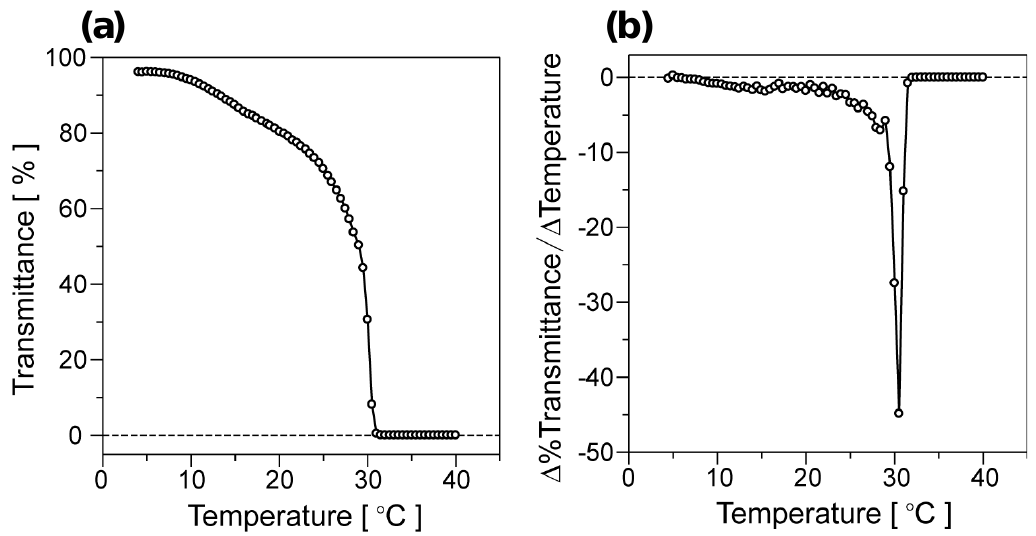
Figure 4. Temperature-dependent optical transmittance variation of poly(NIPAAm- block -NIPAAm- co -PBA) aqueous solutions at the concentration of 5 mg·mL − 1 ( a ) and its differential curve ( b ).